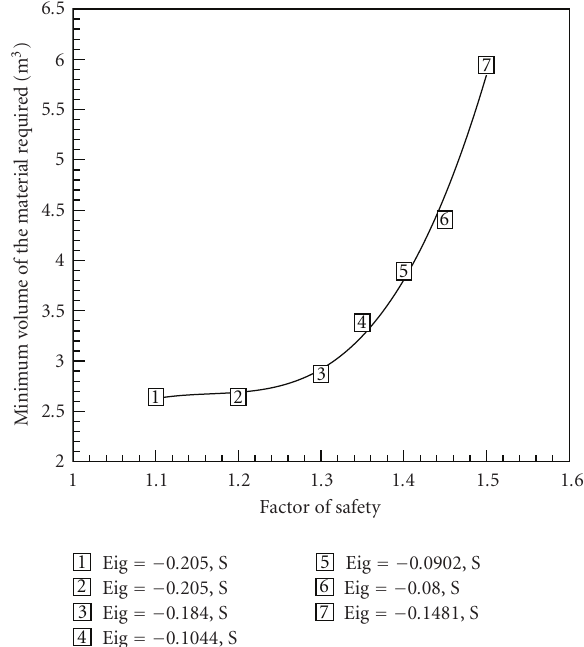
Figure 16: Variation of minimum volume of the material required with